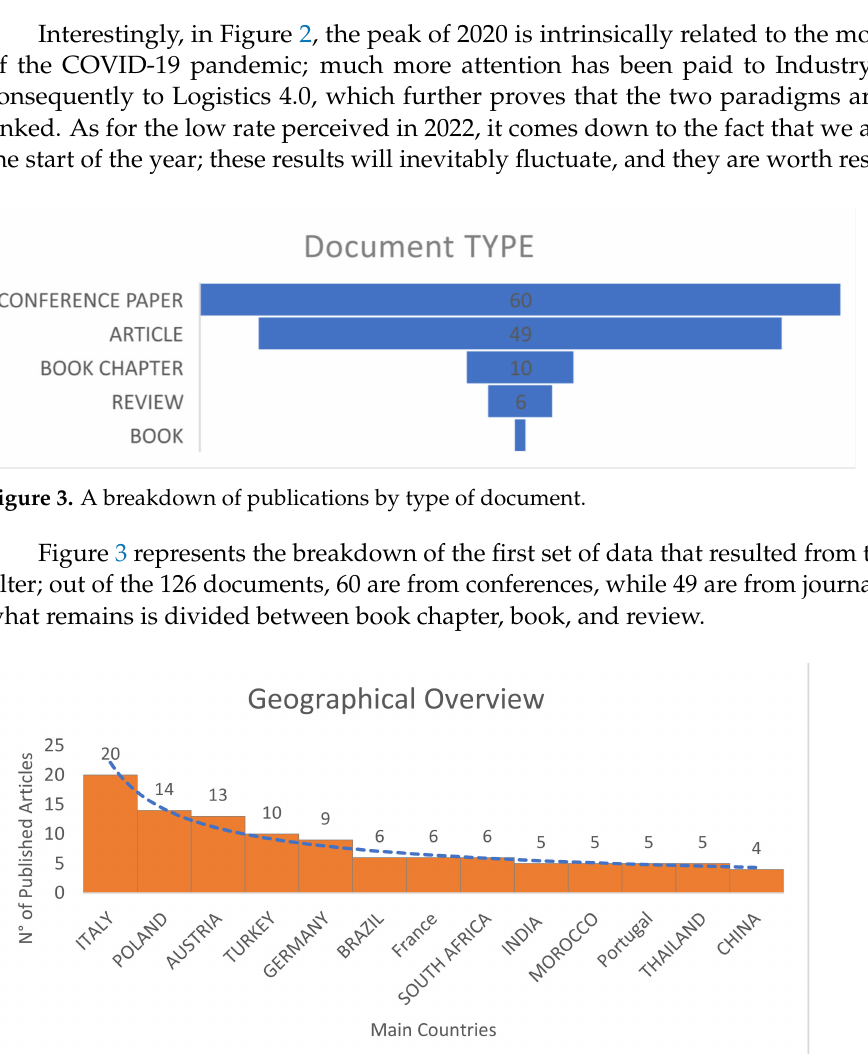
Figure 2. A view of Logistics 4.0-related publications within the last 5 years.